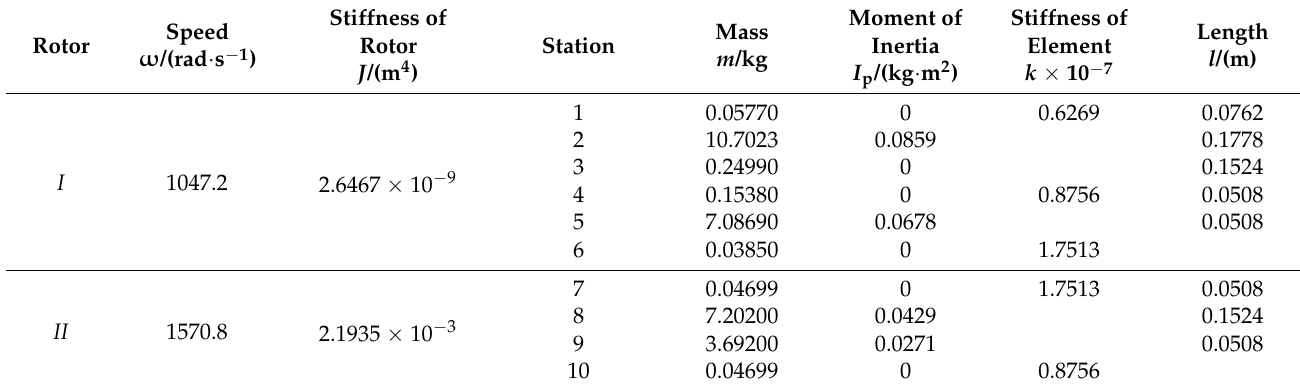
Figure 2. Element division of the dual ‐ rotor system.